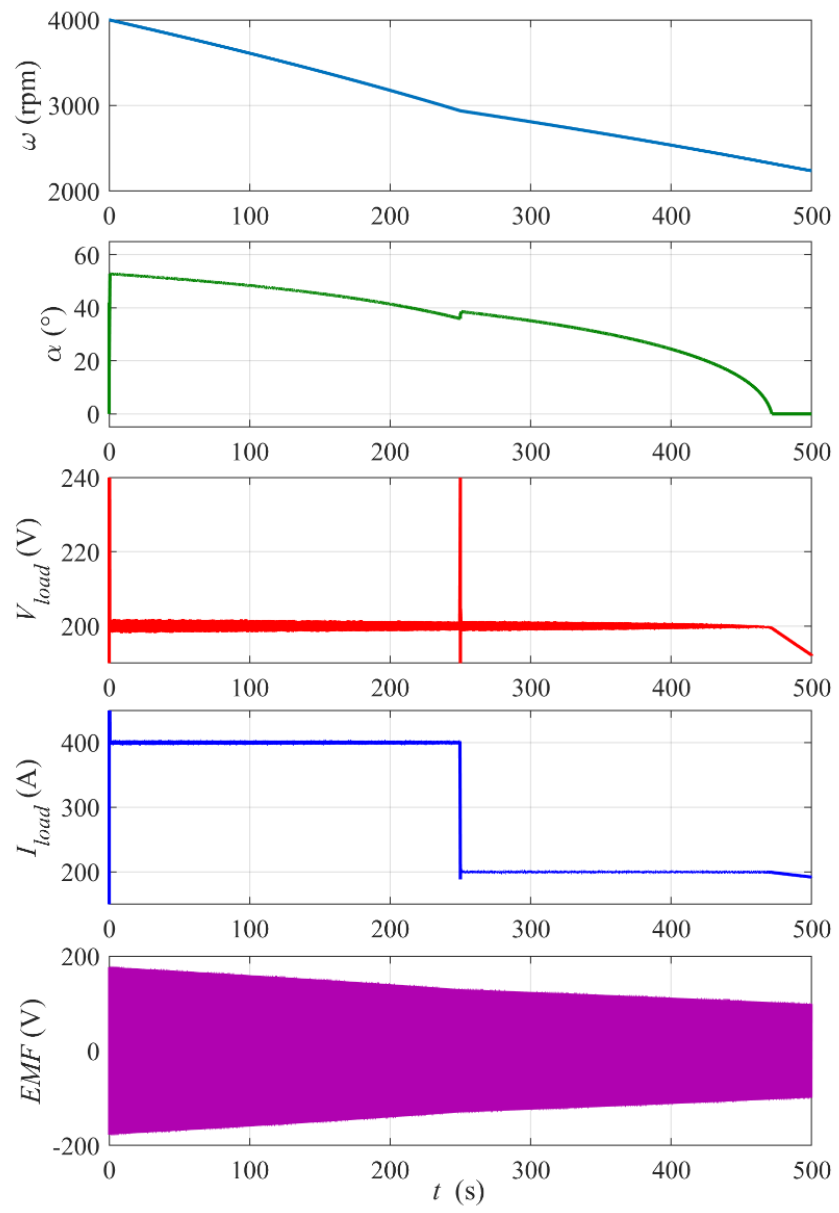
Figure 11. Response of the system to the step change in the load power from 80 kW ( R load = 0.5 Ω) to 40 kW ( R load = 1 Ω) at time t step = 250 s. Reference voltage V load_ref = 200 V, initial rotational speed ω 0 = 40 kW ( R load = 1 Ω ) at time t step = 250 s. Reference voltage V load_ref = 200 V, initial rotational speed 4000 rpm, PI controller settings: k P = 0.03, k I = 1. ω 0 = 4000 rpm, PI controller settings: k P = 0.03, k I =